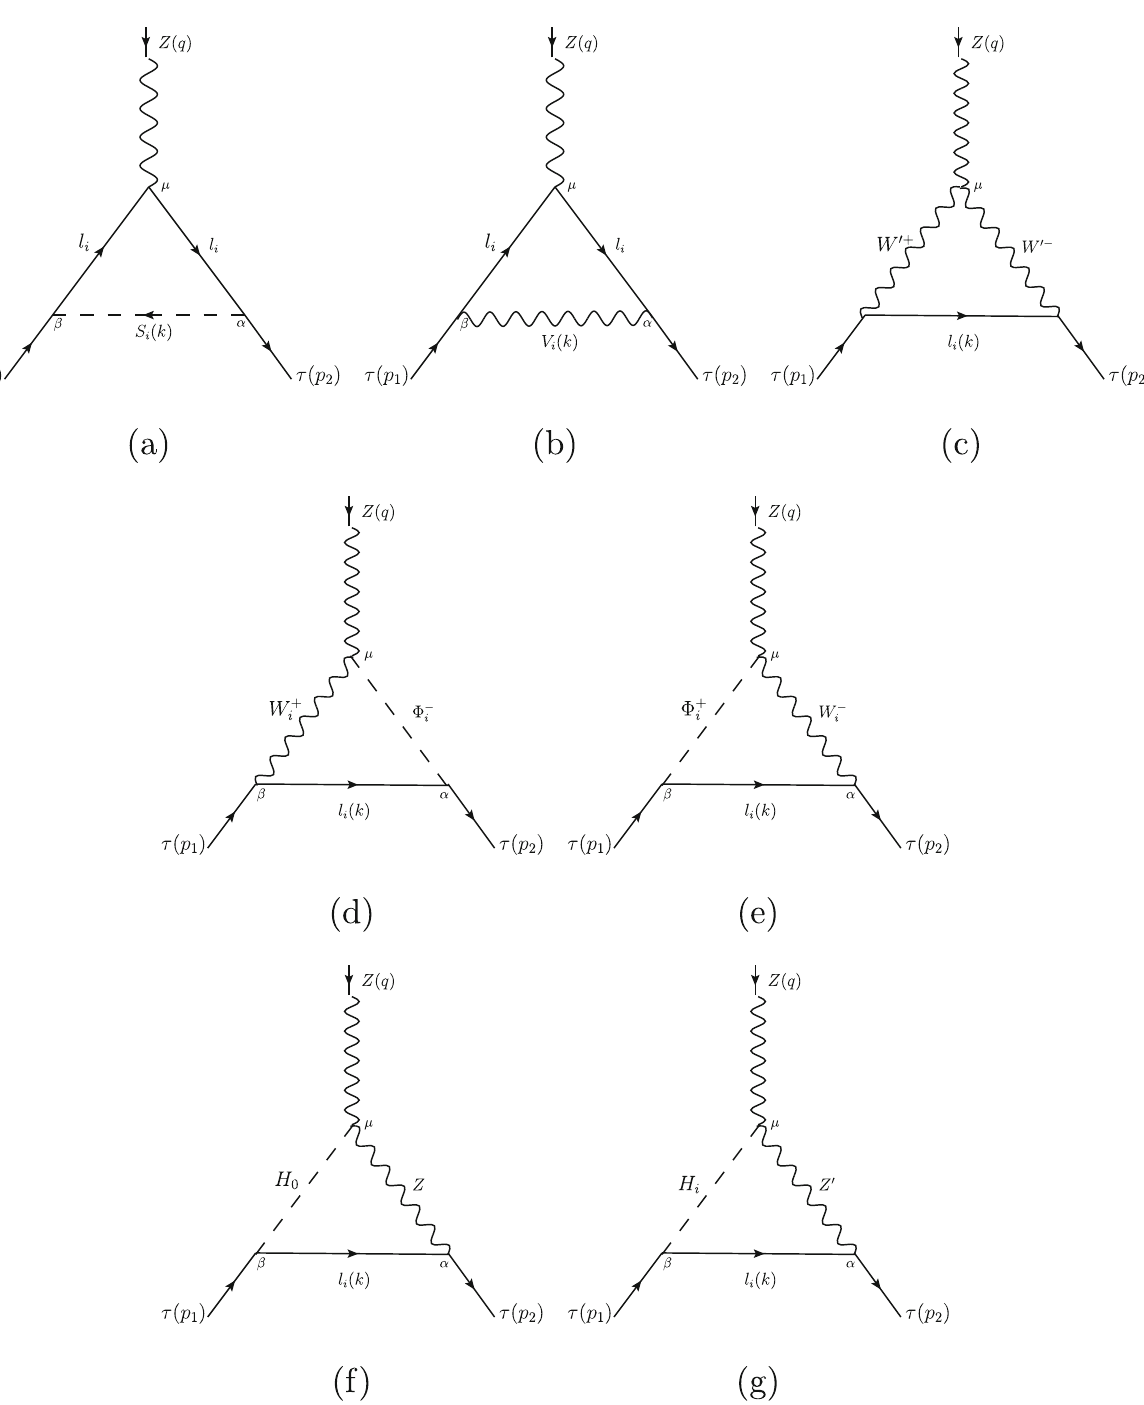
Fig. 2 Generic Feynman diagrams that contribute to the AWMDM of the tau-lepton, l i ≡ τ,ν τ . a Scalar contributions, S i ≡ A 0 , H 0 , H ± ,η 0 ,φ 0 ,σ,η ± ,φ ± . b , c Vector contributions, V i ≡ Z (cid:2) , W (cid:2)± . d – g Scalar–vector contributions, W ± and H i = h 0 , H